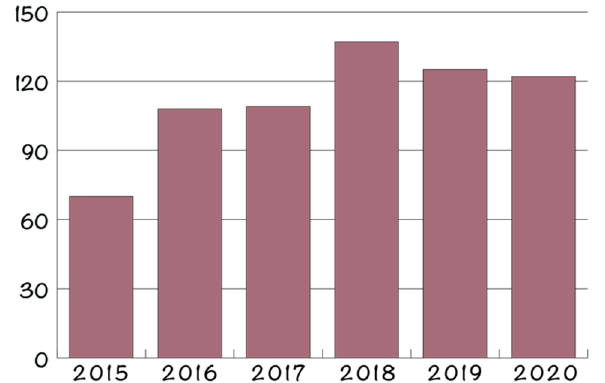
Figure 5. Number of patents between 2015 and 2020 based on therapeutic nanoparticles with antimicrobial activity.